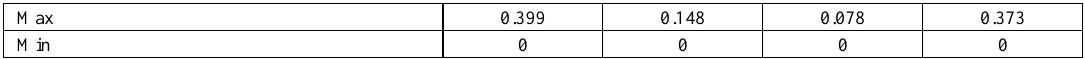
Table 11. Positive idle solution and negative idle solution